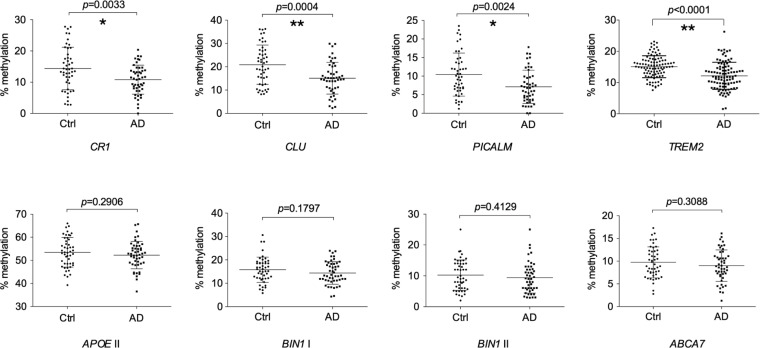
Methylation rates at eight CpG island shores in seven AD-associated genes in the peripheral blood of control and AD subjects.Each dot represents the mean methylation rate at the CpG island shores of the indicated genes in a subject. Subjects were composed of a group of 48 cognitive normal elderly (Ctrl) and 48 AD patients, named the test group, except for TREM2, for which another set of 96 subjects, named the replication group, was also examined. Methylation rates were quantified by Sanger sequencing, except for TREM2, for which pyrosequencing was employed [33]. The relative position of the CpG island shore investigated in APOE was region II in Fig 1, whereas those in the other six genes are shown in S1–S6 Figs. The horizontal lines and error bars indicate the mean ± standard deviation. p-values were obtained using the Student’s t-test. Statistical significance was defined at *p < 0.00625, **p < 0.00125 following Bonferroni correction. Abbreviations: Ctrl, control; AD, Alzheimer’s disease.